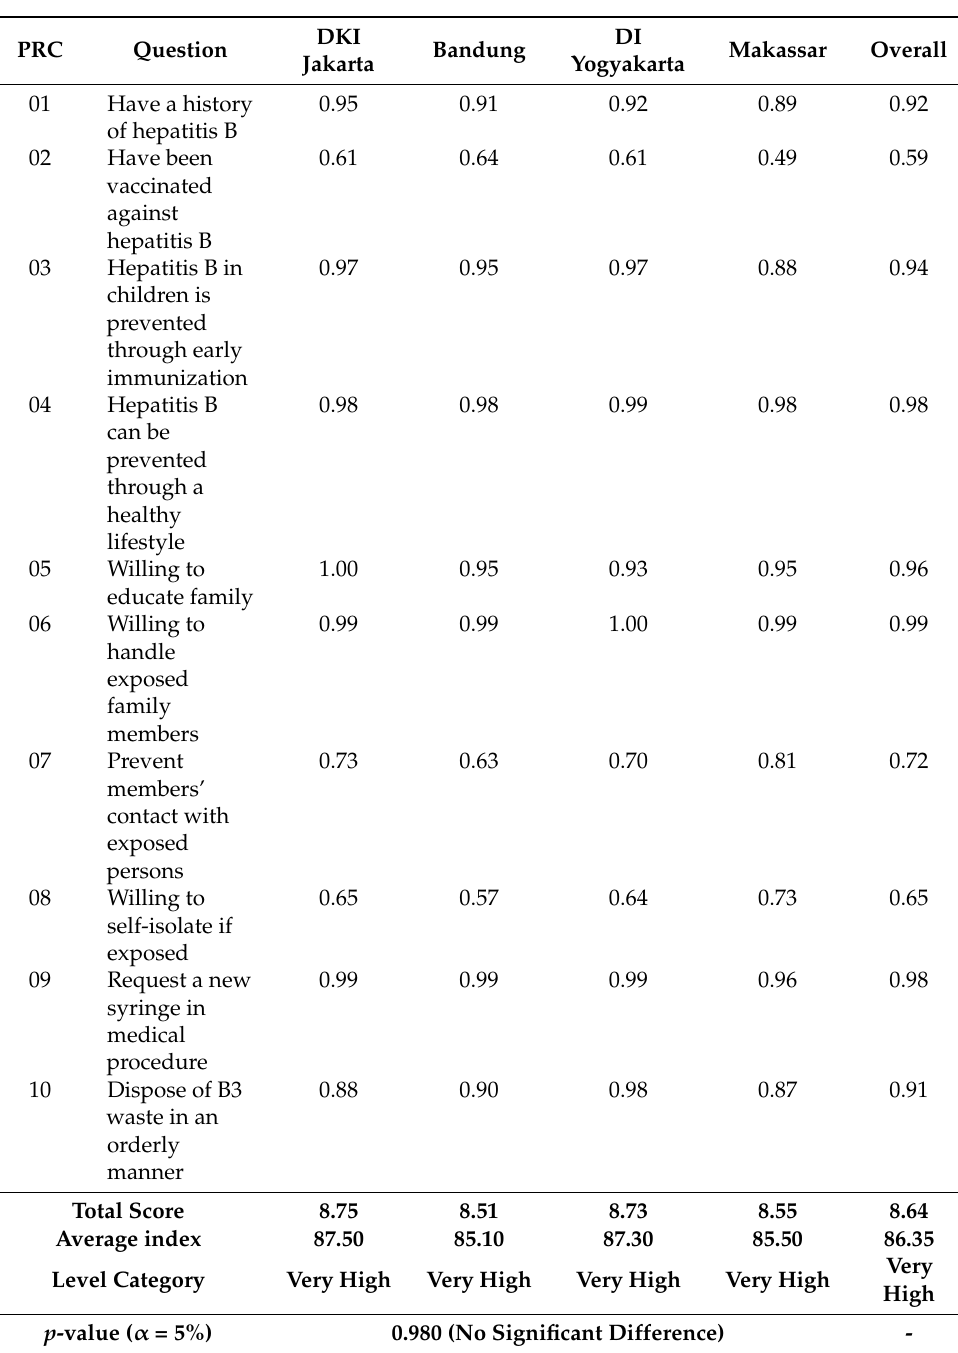
Table 5. Practice/Behavior in preventing hepatitis B among